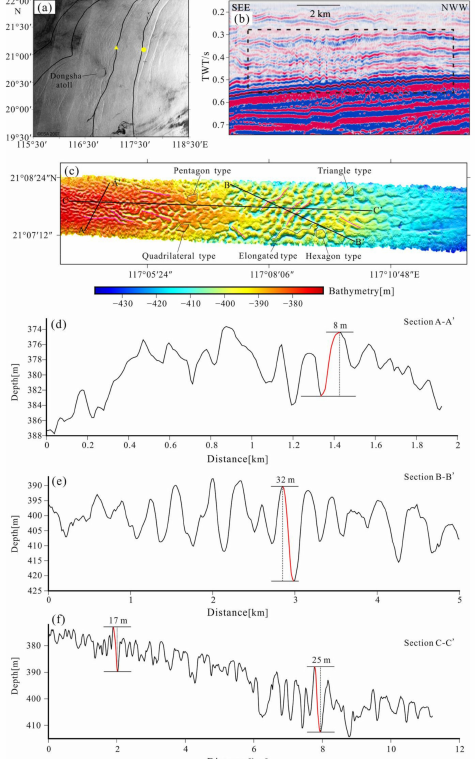
Figure 8. ( a ) Synthetic Aperture Radar (SAR) image around the Dongsha atoll (modified after [72]). The ripples represent the propagation of the internal solitary waves, and the black lines represent the wave fronts of the main internal solitary. The yellow triangle represents the distribution area of the submarine reticular dunes, and a yellow dot represents the areas where the parallel dunes are located. ( b ) Seismic reflection image collected in the northeast of the Dongsha atoll (modified after [13]). The image shows the development of the internal solitary waves with high frequency oscillation above the submarine reticular dunes. ( c ) Multi-beam bathymetric map of the submarine reticular dunes in the northeastern part of the Dongsha atoll (polygonal and elongated types). The purple solid lines represent the extending direction (E–W, NE and NWW) of the ridge lines of the reticular dunes. The detailed location of the reticular dunes is shown in Figure 1b. ( d ) The vertical cross section (A–A’) of the reticular dunes shown in ( c ). ( e ) The vertical cross section (B–B’) of the reticular dunes shown in ( c ). ( f ) The vertical cross section (C–C’) of the reticular dunes shown in ( c ). The maximum height difference of the reticular dunes is shown in the